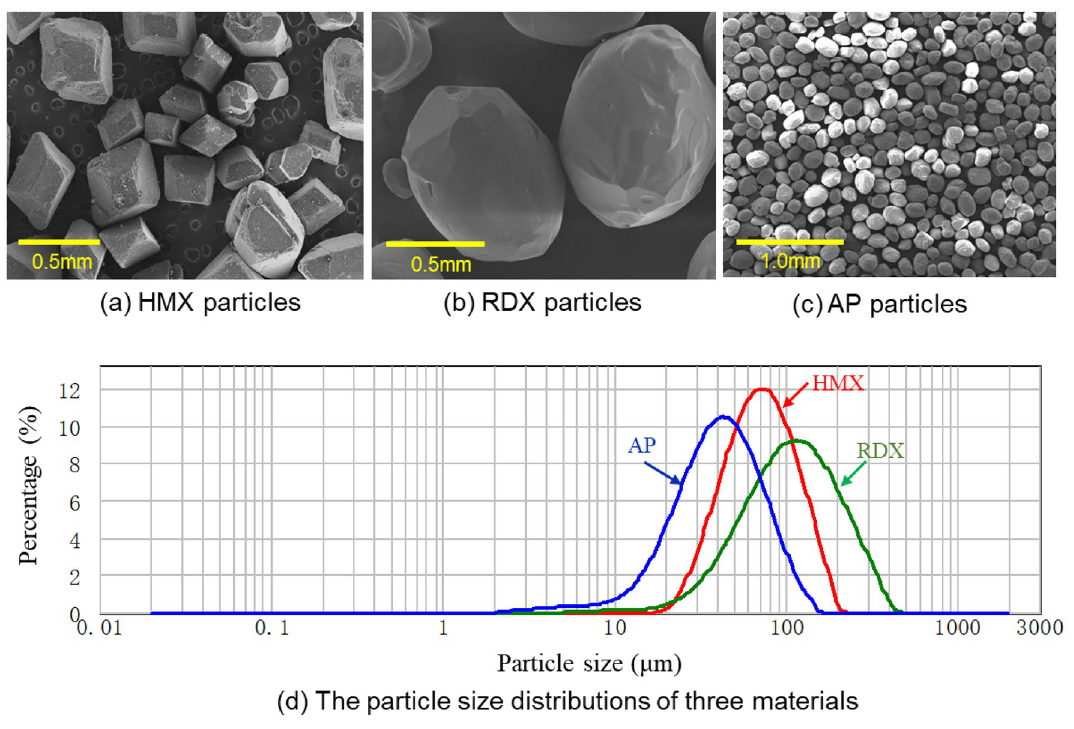
Fig. 1 The typical particles of three energetic materials and their particle size